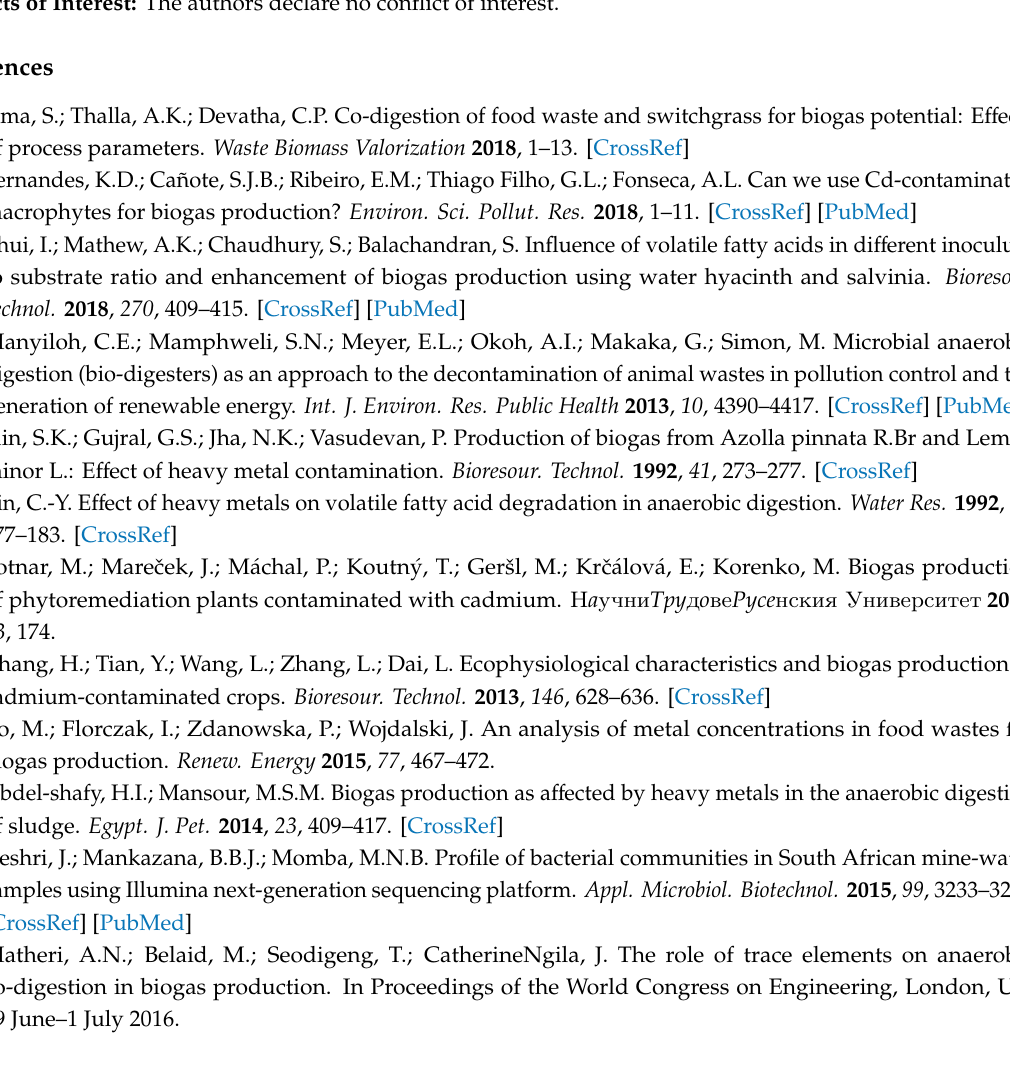
Figure S1. CH4 contents under Cd stress with digestion temperatures of 55 ◦ C, 45 ◦ C, 35 ◦ C, and 25 ◦ C; Figure S2: Volatile fatty acids (VFAs) ratio of the Cd-added group to no Cd-added group with digestion temperatures of 55 ◦ C ( a ), 45 ◦ C ( b ), 35 ◦ C ( c ), and 25 ◦ C ( d ). The blue dash line indicates a ratio of 1, i.e., the same amount of VFAs in the Cd-added and no Cd-added